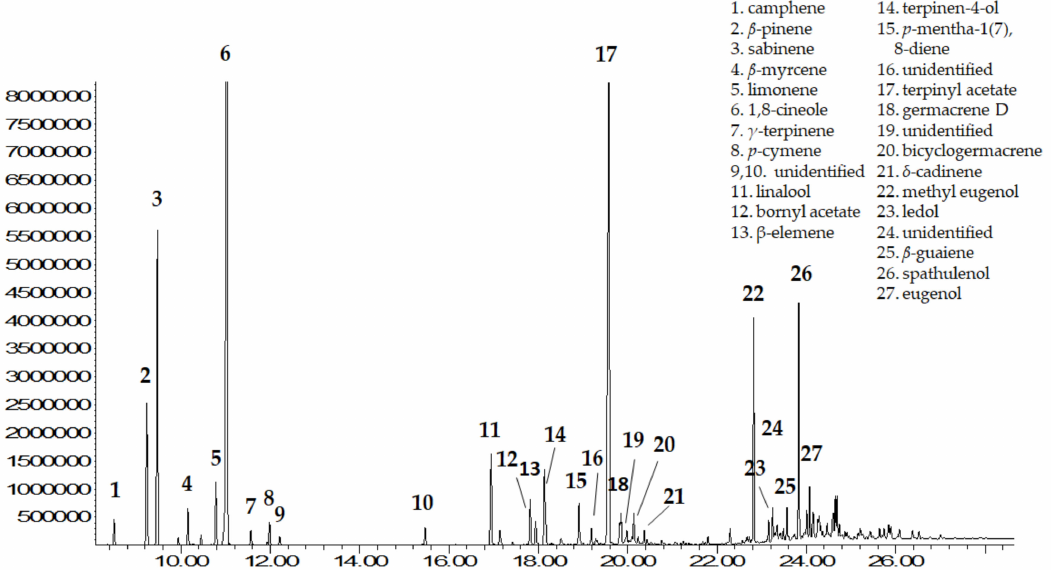
Figure 3. GC-MS chromatographic profile of bay laurel leaf EO under the conditions described by Ordoudi and collaborators